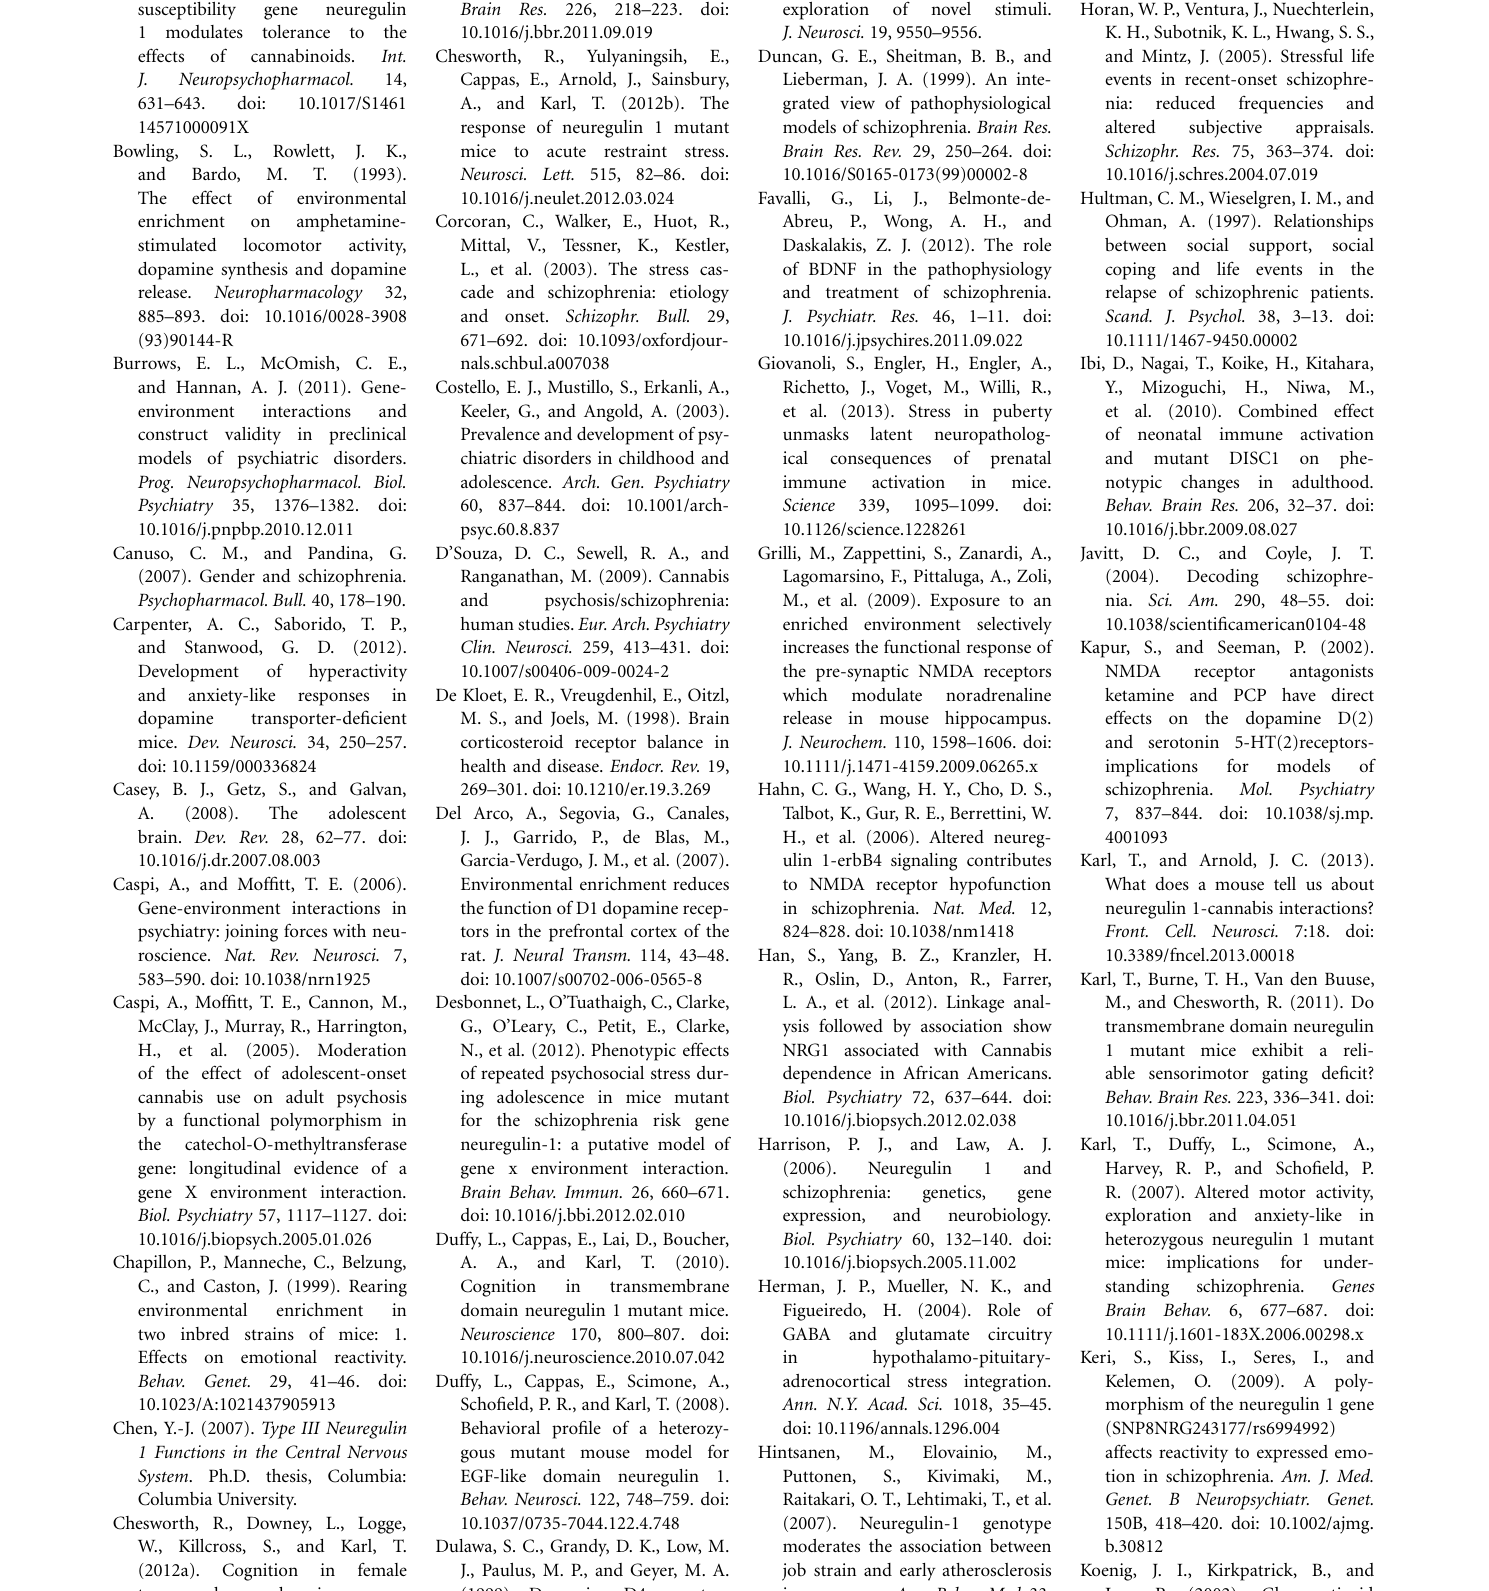
Figueiredo, H. (2004). Role of GABA and glutamate circuitry in hypothalamo-pituitary- adrenocortical stress